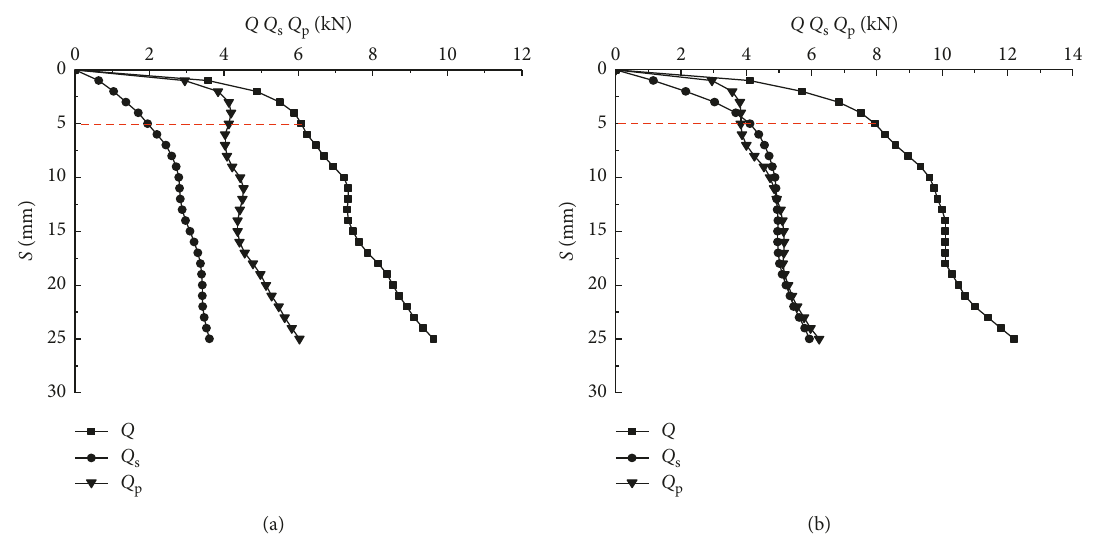
Figure 15: Load-settlement curves of pile groups. (a) 3 b pile spacing. (b) 6 b pile